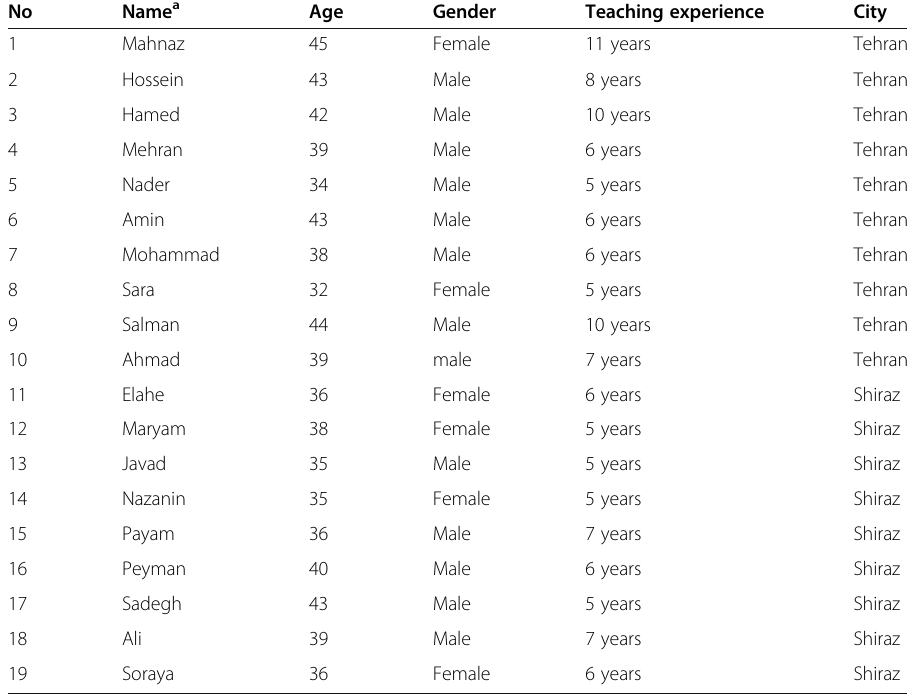
Table 2 Demographic information about the